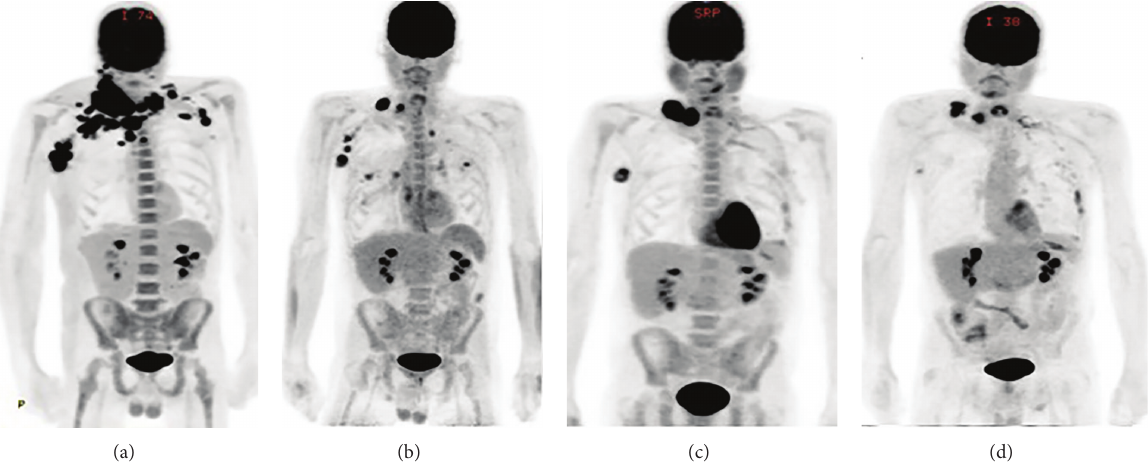
Figure 3: (a) PET scan at presentation, (b) PET scan done after 6 cycles of AVD, (c) PET scan after 8 cycles of AVD, and (d) PET scan after 2 cycles of brentuximab.